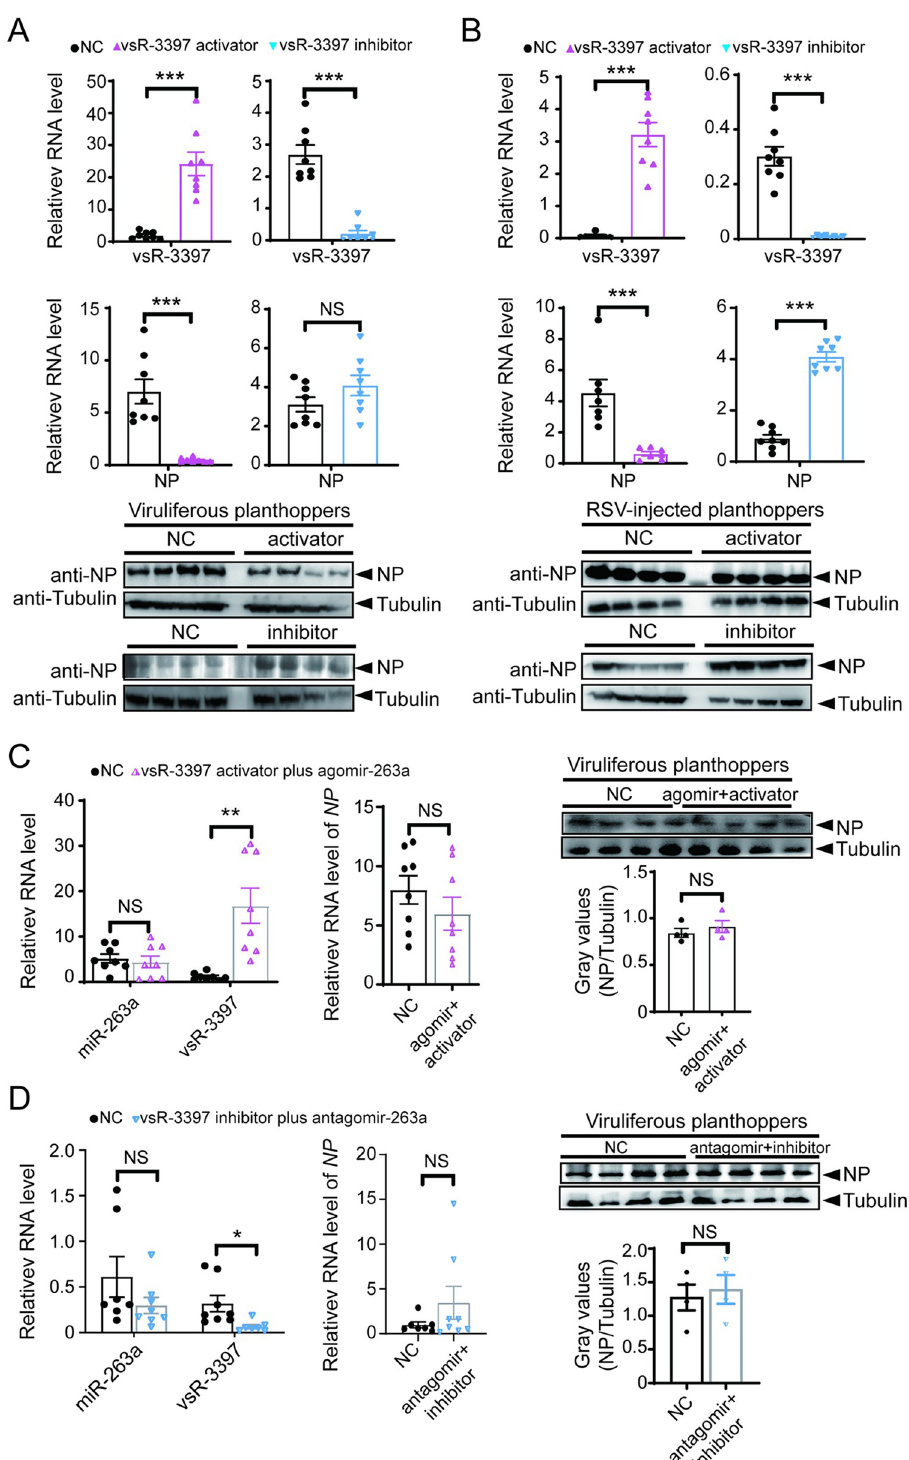
Fig 6. vsR-3397 inhibits RSV replication by affecting miR-263a. (A) and (B) Relative RNA levels of vsR-3397 and RSV NP (n = 8) and the protein level of NP (n = 4) in the viruliferous planthoppers after injection with the vsR-3397 activator or inhibitor for 4 d (A) and in the nonviruliferous planthoppers after injection with the mixture of RSV and the activator or inhibitor of vsR-3397 for 6 d (B). (C) and (D) Relative RNA levels of miR-263a, vsR-3397 and RSV NP (n = 8) and protein level of NP (n = 4) in the viruliferous planthoppers after injection with the mixture of vsR-3397